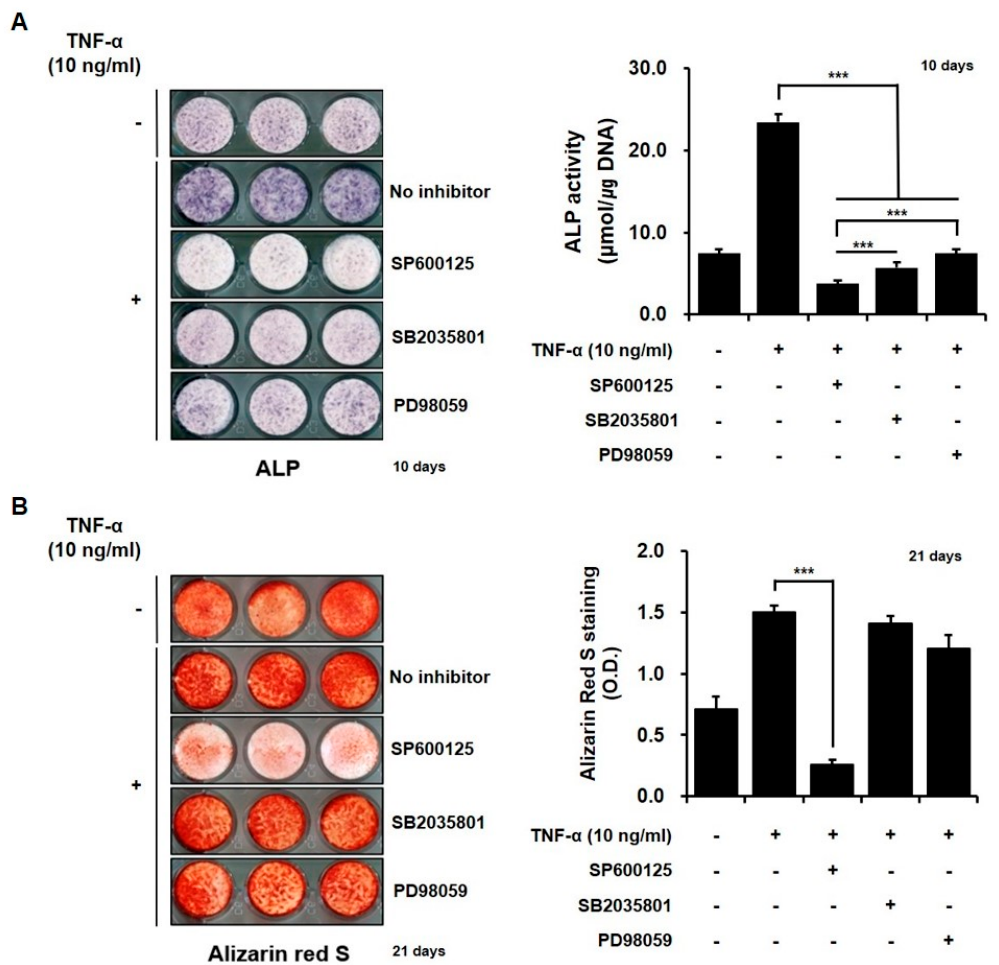
Figure 4. Effects of MAPKs on the in vitro osteoblastic differentiation of hPDCs treated with TNF- α . ALP activity decreases in hPDCs pretreated with all three MAPK inhibitors ( A ). SP 600125 shows the most potent inhibition of ALP activity, among all tested MAPK inhibitors. In line with the ALP results, alizarin red-positive mineralization was significantly decreased in hPDCs pretreated with the JNK-specific inhibitor ( B ). *** p < 0.001.